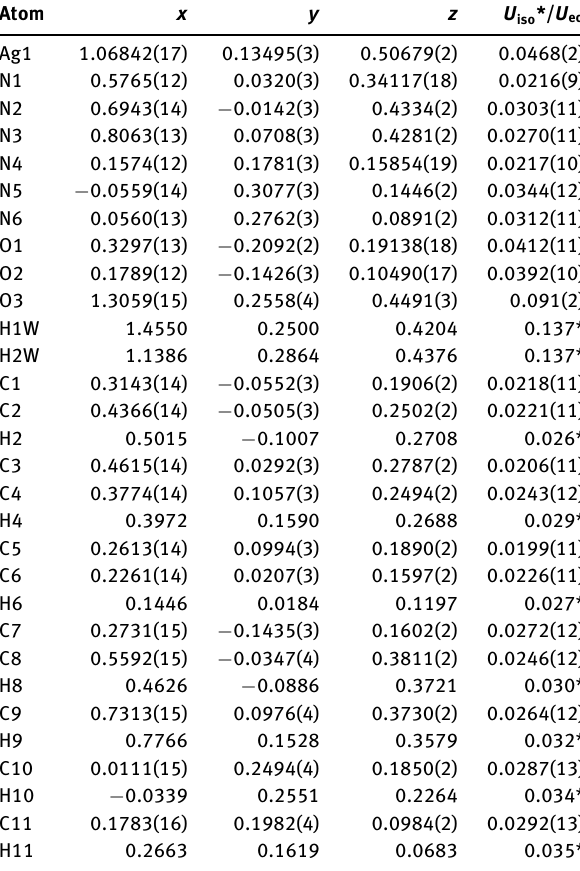
Table 2: Fractional atomic coordinates and isotropic or equivalent isotropic displacement parameters (Å 2